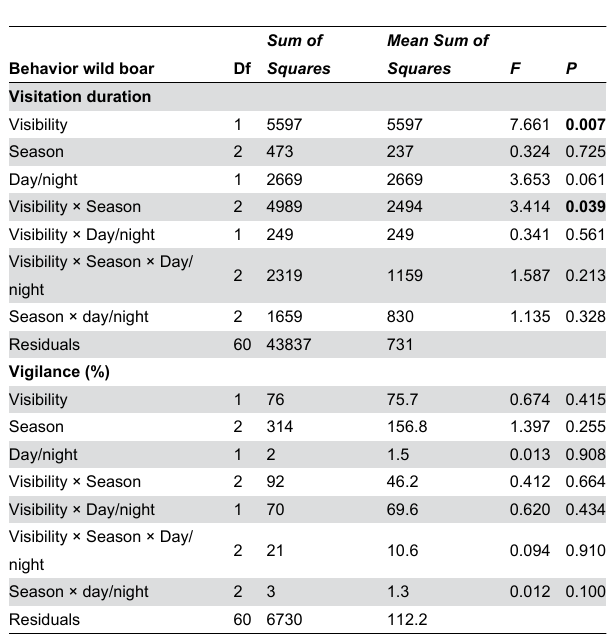
Table 2. Behavior of wild boar in relation to habitat visibility (study 1).